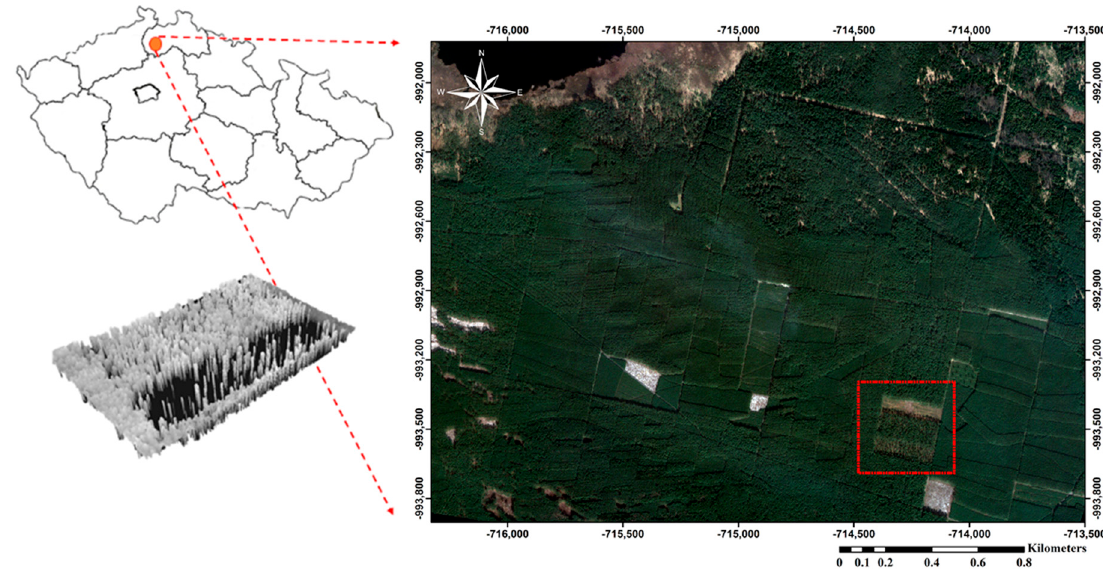
Figure 1. Location of the study area in Doksy, Czech Republic in a local coordinate system (S-JTSK/Krovak East North) source: Pléiades-1A satellite image taken in 2017.